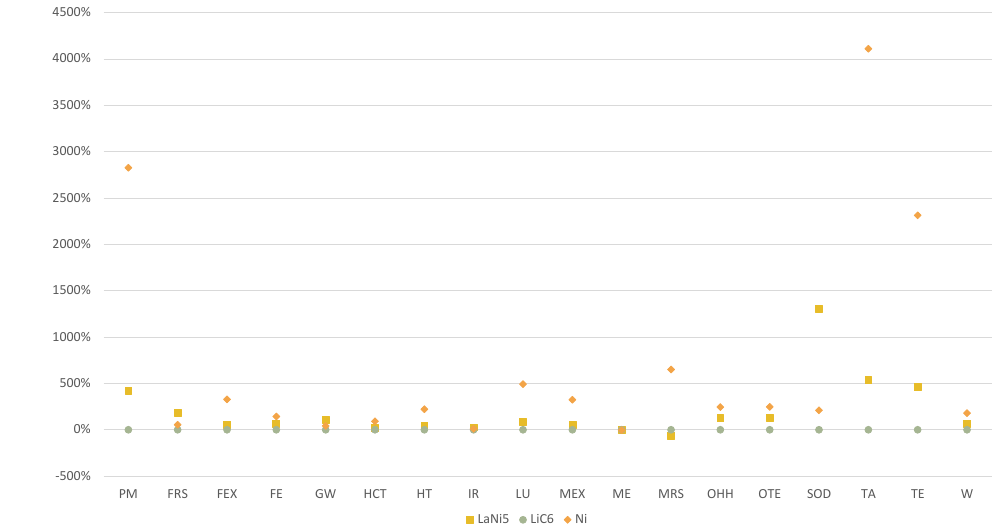
Figure 7. Sensitivity analysis on mechanical recycling. According to different providers of electrode production, some of the impact categories are affected by the results. Compared to LiC6, which is the base case, the highest and the lowest variability is observed, respectively, for Terrestrial acidification and Marine eutrophication categories.